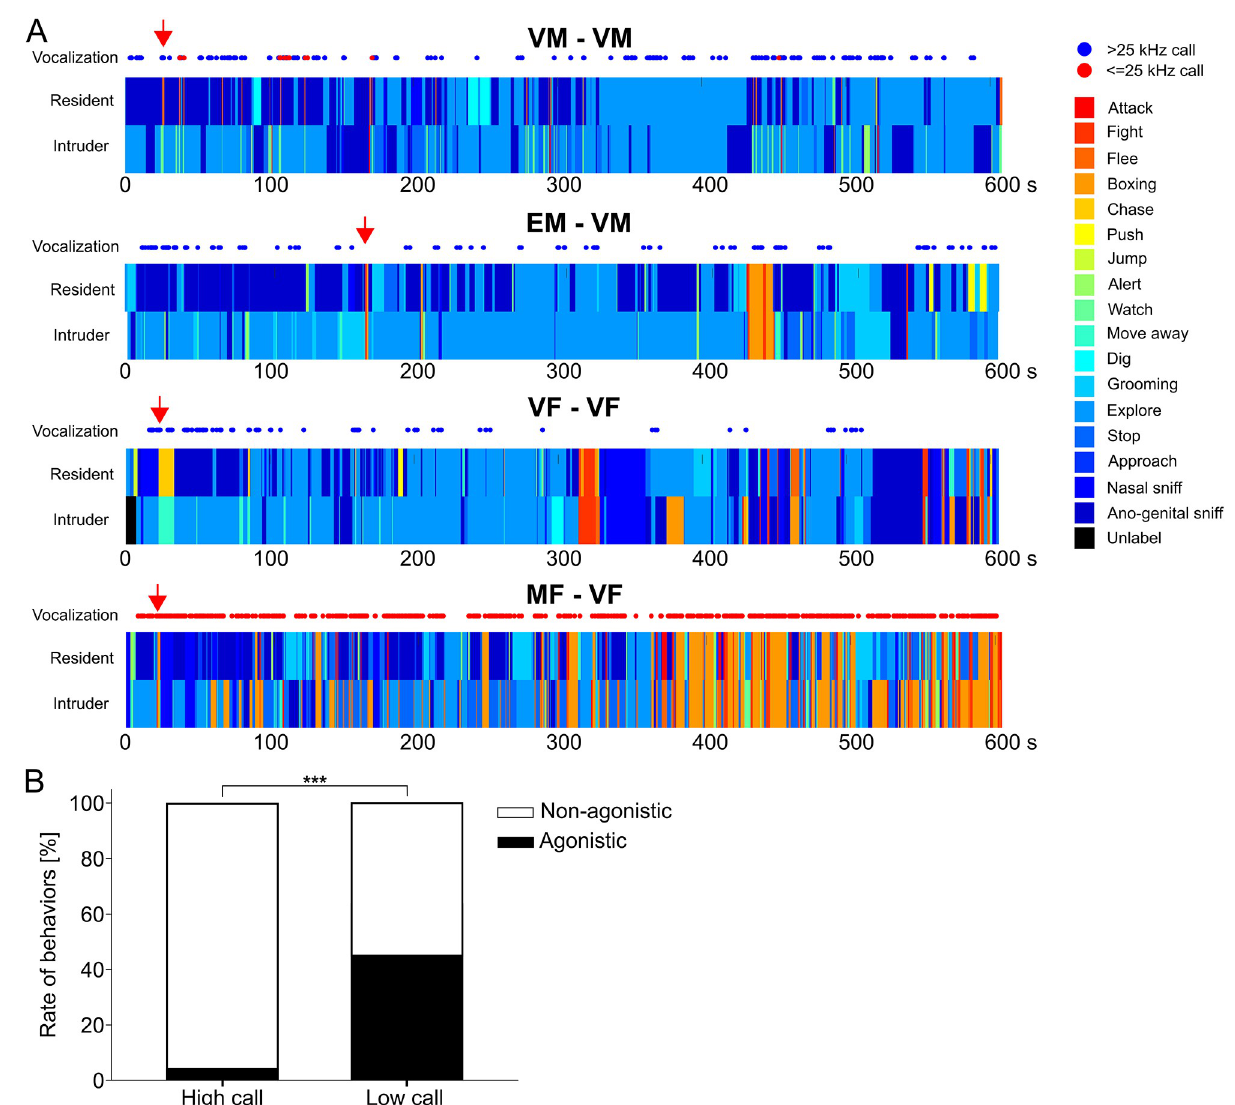
Fig 6. Relation between two types of calls and each behavior. (A) Representative ethograms of each pair-test during resident-intruder tests. Ethograms for VM-VM, EM-VM, VF-VF, and MF-VF pairs were aligned from top to bottom. Bluish colors represent non-agonistic behaviors and reddish colors represent agonistic behaviors. Blue circles and red circles indicate > 24.6 kHz calls and 24.6 � kHz calls respectively. Red arrows indicate the timing when the resident initiated the first aggressive behavior. MF-VF pairs exhibited different patterns of vocalizations and behaviors. (B) The ratio of behaviors at the timing each call emitted. At the timing of high-frequency calls, agonistic interactions were rarely observed, contrary, at the timing of low-frequency calls, agonistic interactions were dominant. ��� represents p < 0.001.